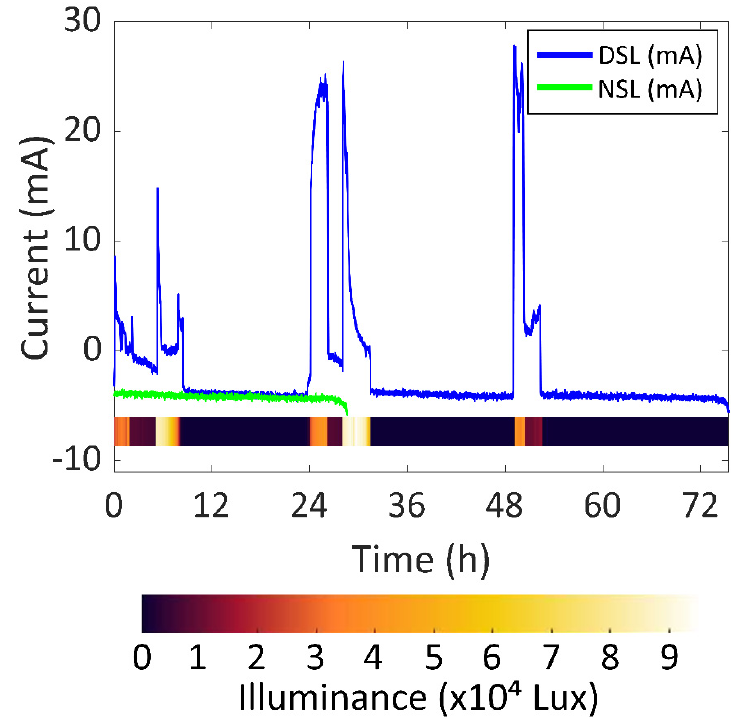
Figure 11. Battery current vs. time of DSL and NSL experiments.